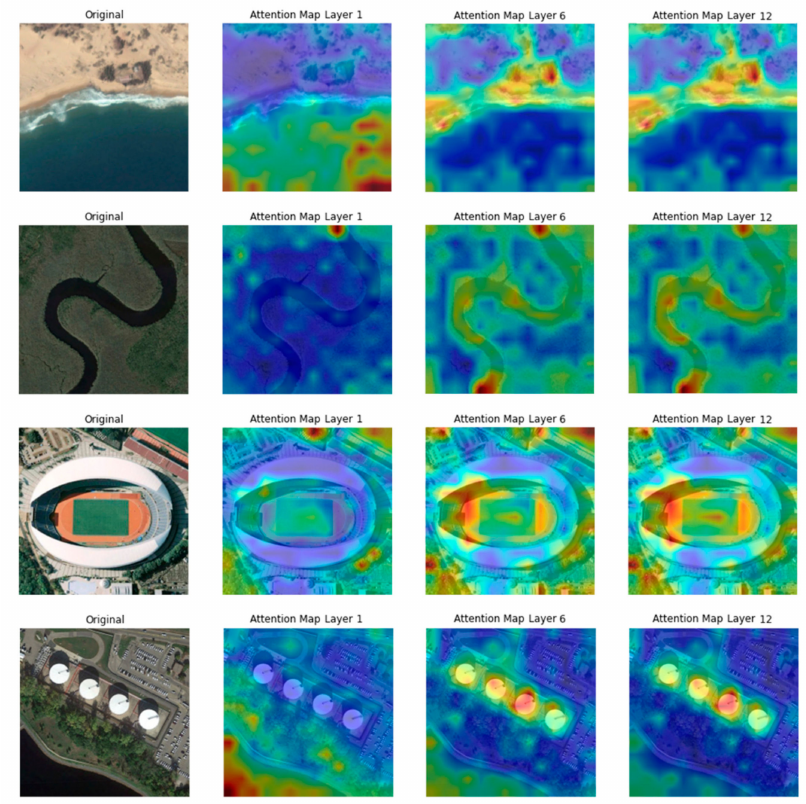
Figure 7. The class attention maps resulted from different encoder’s layers for the AID